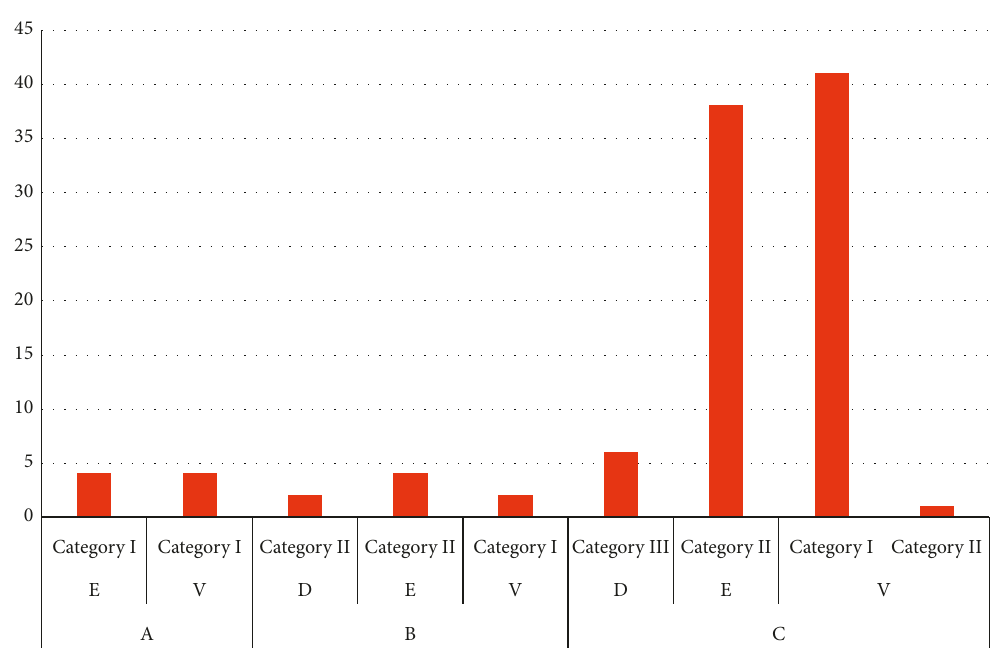
Figure 3: Distribution of inventoried item into categories. Table 6: Category I item groups according to supplier